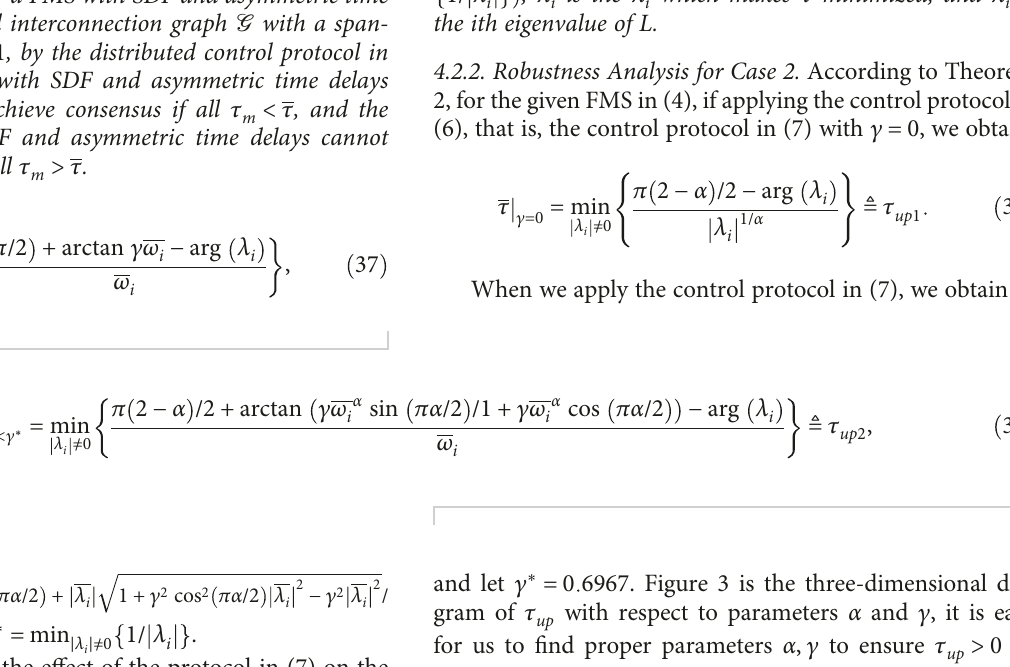
Figure 3: The three-dimensional diagram of τ parameters α and γ in case